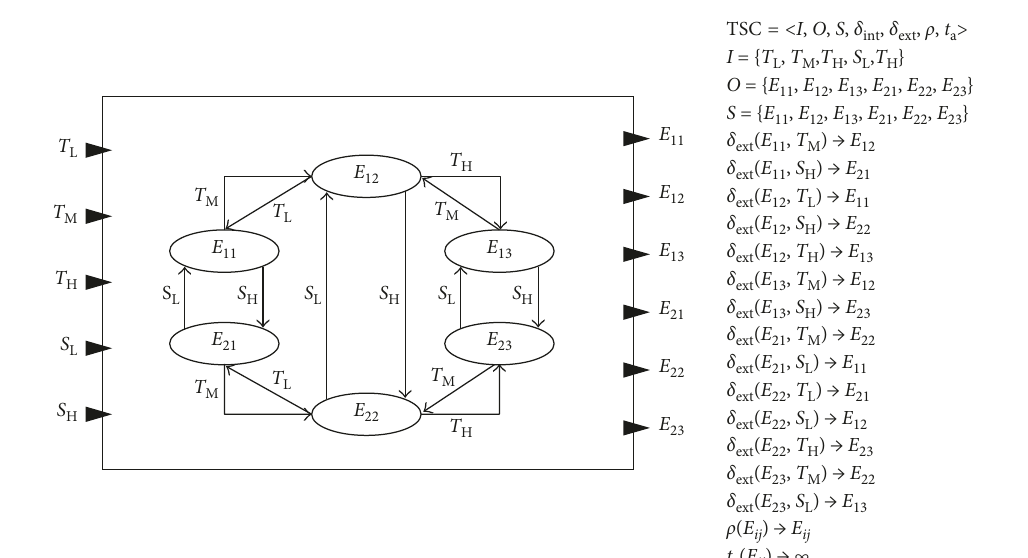
Figure 4: DEVS model for a traffic signal controller under various environmental conditions.